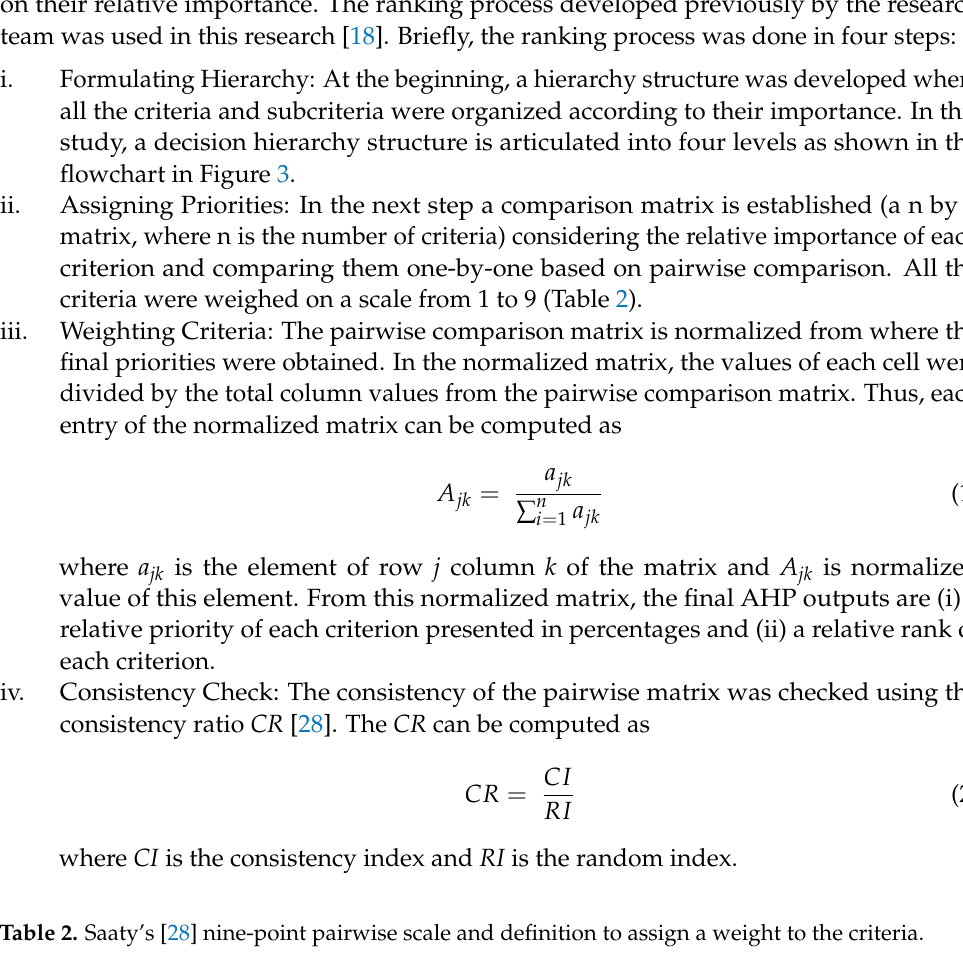
Table 2. Saaty’s [28] nine-point pairwise scale and definition to assign a weight to the criteria. Intensity of